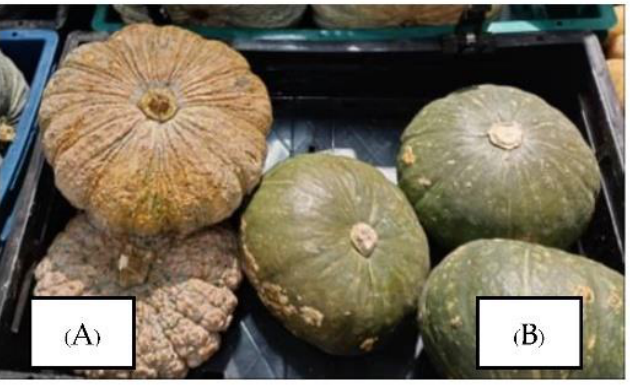
Figure 1. Traditional pumpkin ( Cucurbita moschata Duchesne) ( A ) and Japanese pumpkin ( C . maxima Duchesne) ( B ).